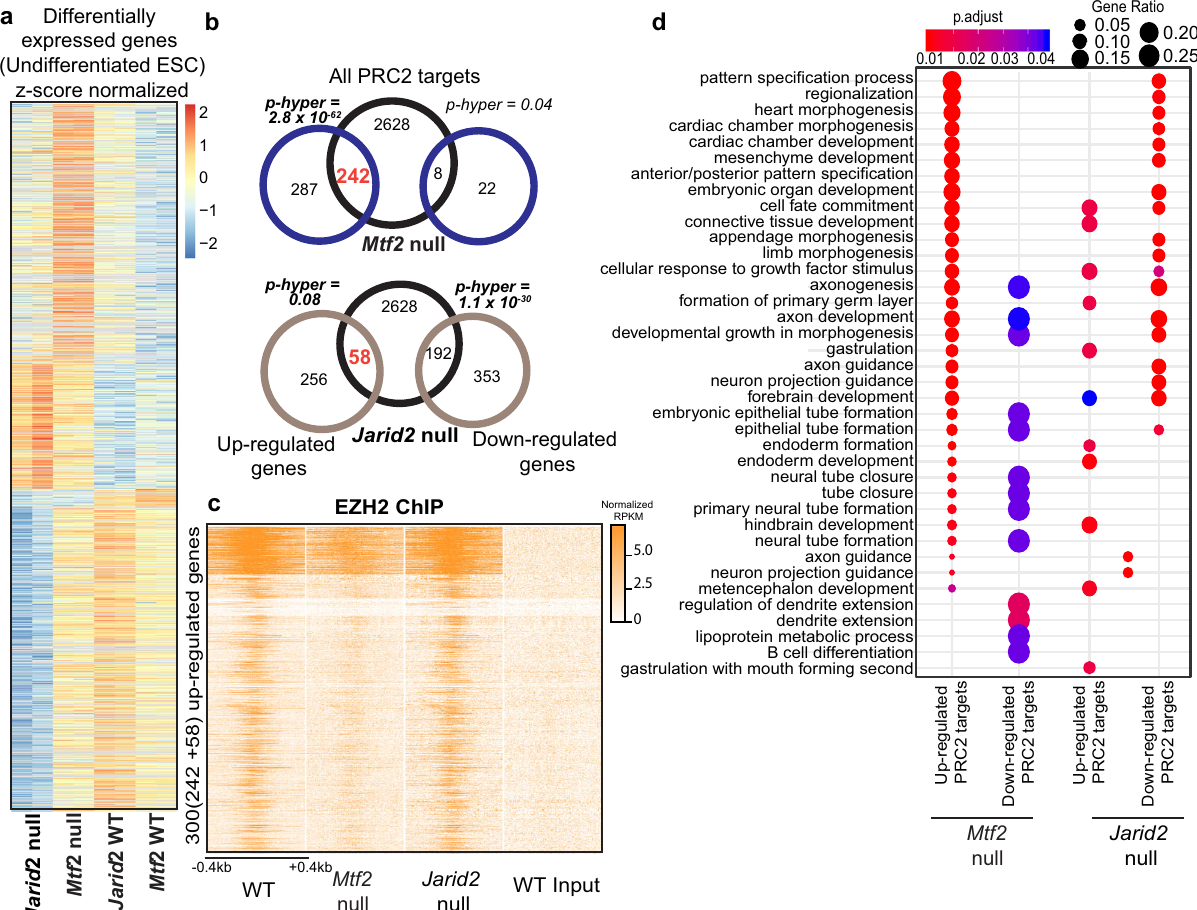
Fig. 4 Derepression of PRC2 targets in Mtf2 and Jarid2 null ES cells. a Heatmap of differentially expressed genes comparing different mutants against WT in undifferentiated mESCs. Z-score normalized counts (row scaling) are shown in heatmap. b Venn diagram depicting overlap of a number of genes which were up/downregulated in Mtf2 null and Jarid2 null cells, with PRC2 targets (as determined from EZH2 ChIP targets; next panel). Signi fi cance of overlap calculated using hyper-geometrical test. c Heatmap of EZH2 binding peaks (RPKM normalized) for upregulated genes (from Mtf2 and Jarid2 null ESCs) for different genetic backgrounds. Heatmap depicts a window of + / − 400 bp from the transcription start site (TSS) of the genes. d Dot plot showing the enriched Gene Ontology terms for the differentially expressed genes in different genetic